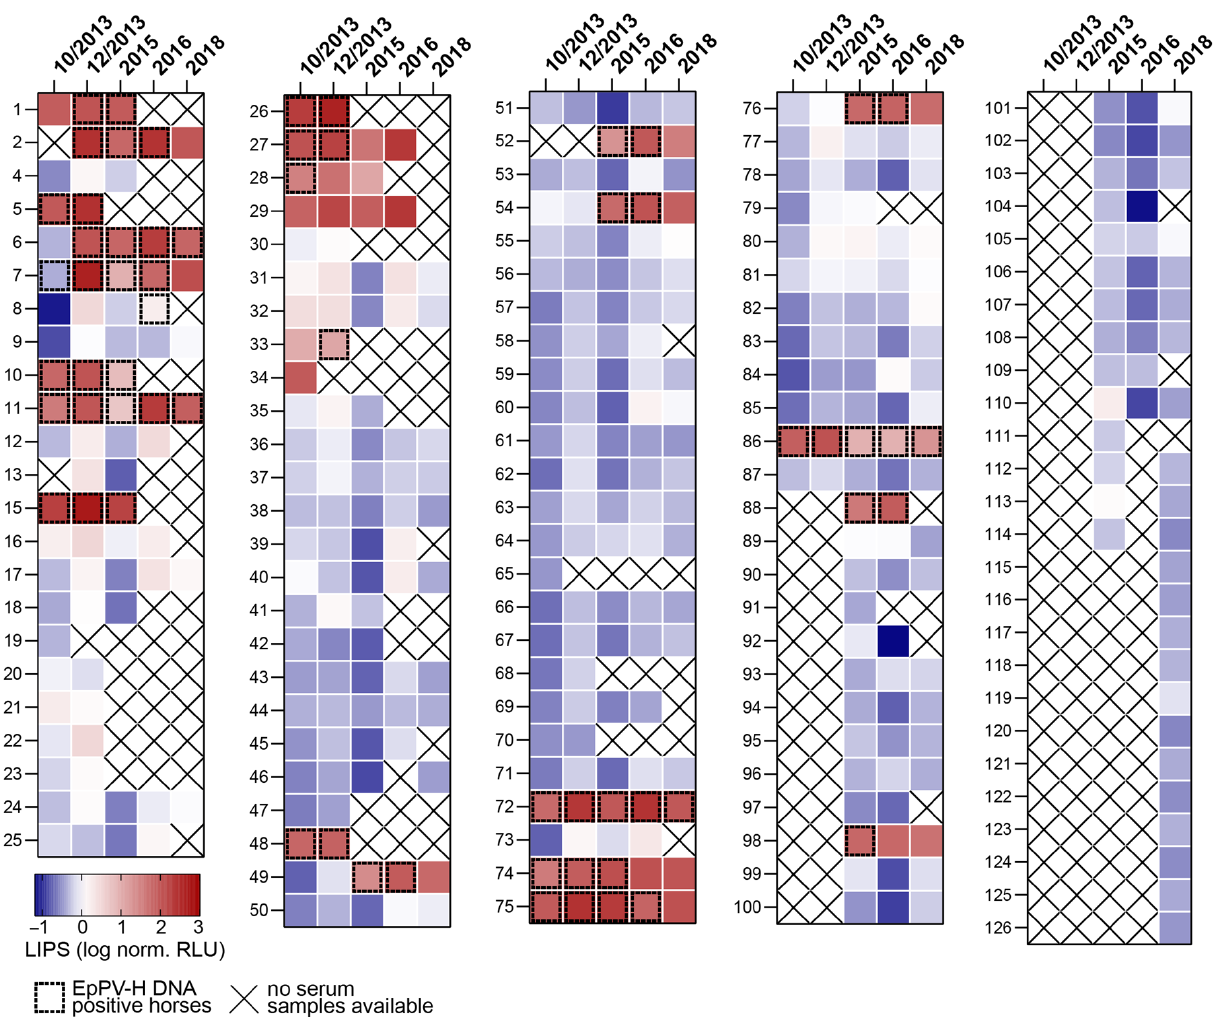
Figure 1. Study cohort overview. EqPV-H DNA was measured by qPCR, and antibodies against VP1 were determined by LIPS assay in horse serum taken at different dates. LIPS results of horse samples available for testing from October 2013 to 2018 are depicted as heatmaps. X indicates when serum samples were not available. Normalized RLU are shown as heat map. Antibodies measured in RLUs were normalized per plate as fold over threshold. Dotted squares indicate samples that were either tested positive by qPCR or deemed positive by detection of virus specific amplification on agarose